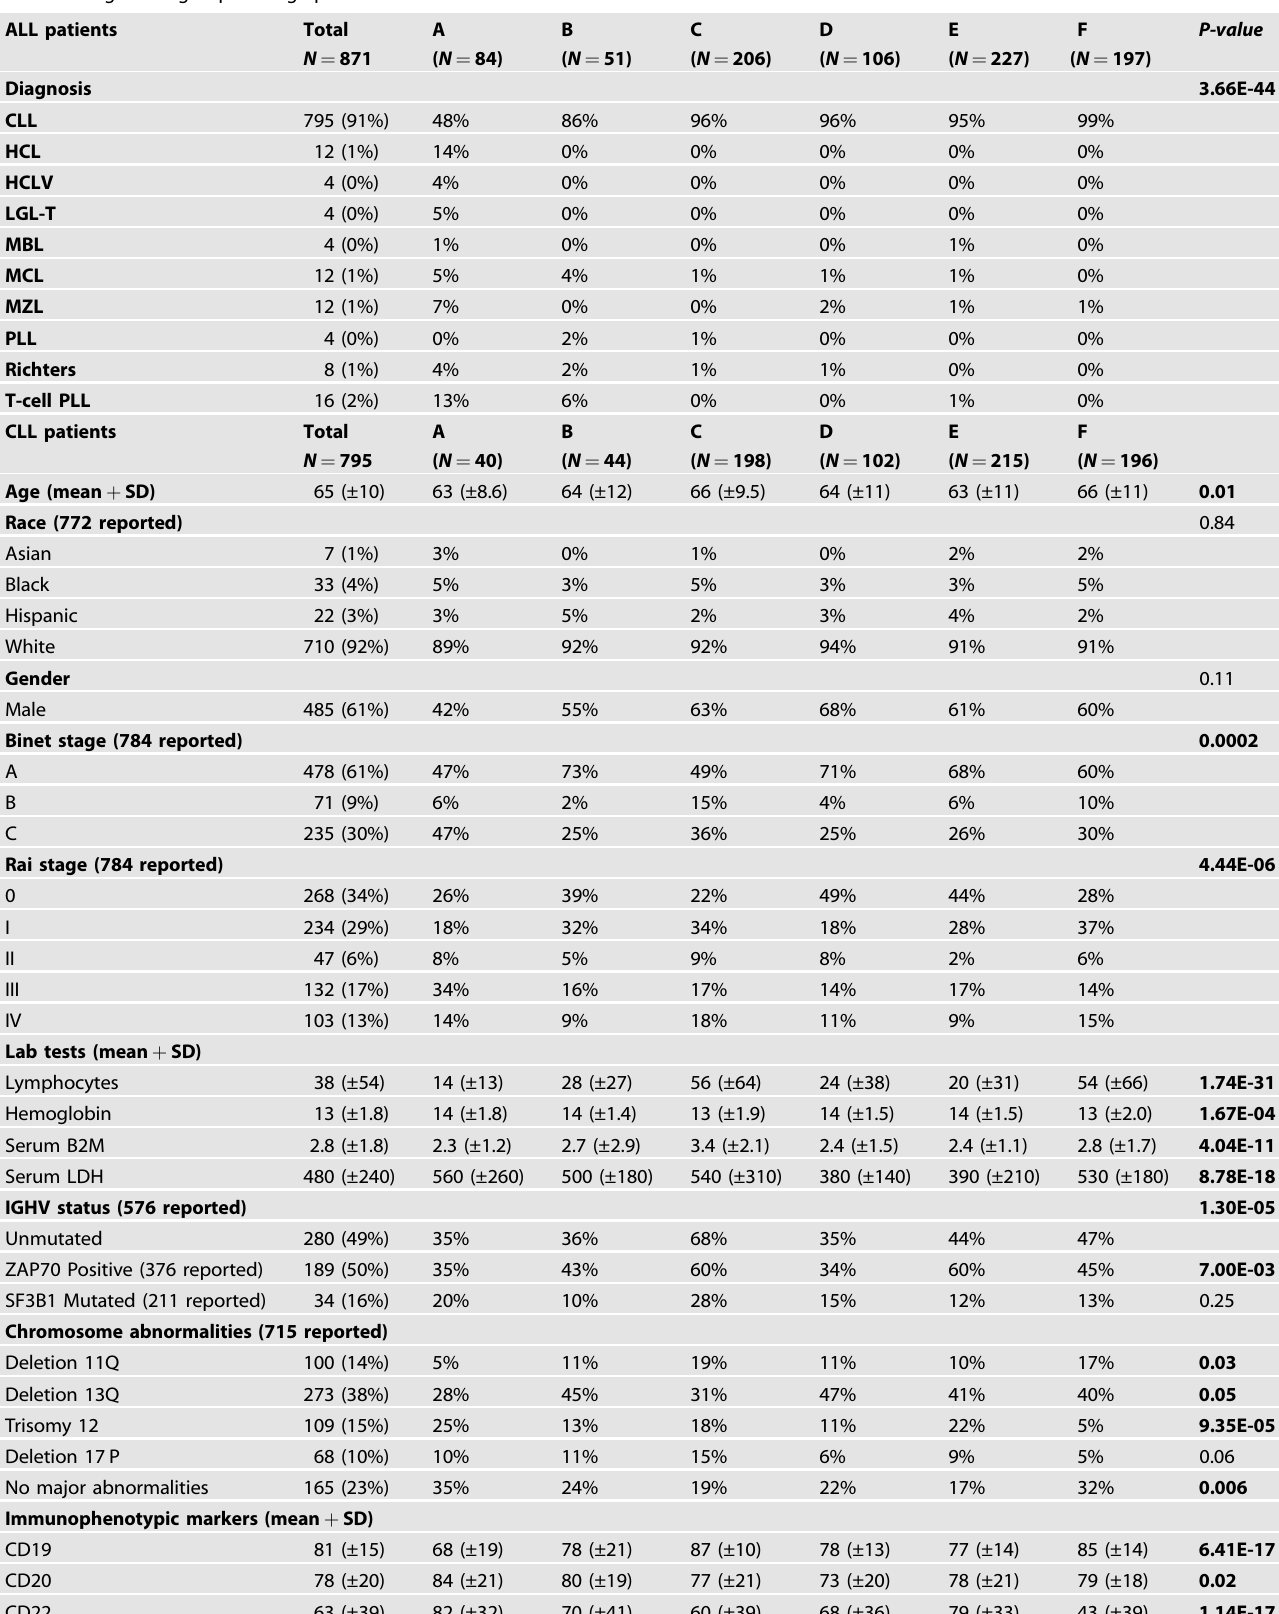
Table 1. Signature group demographics and clinical